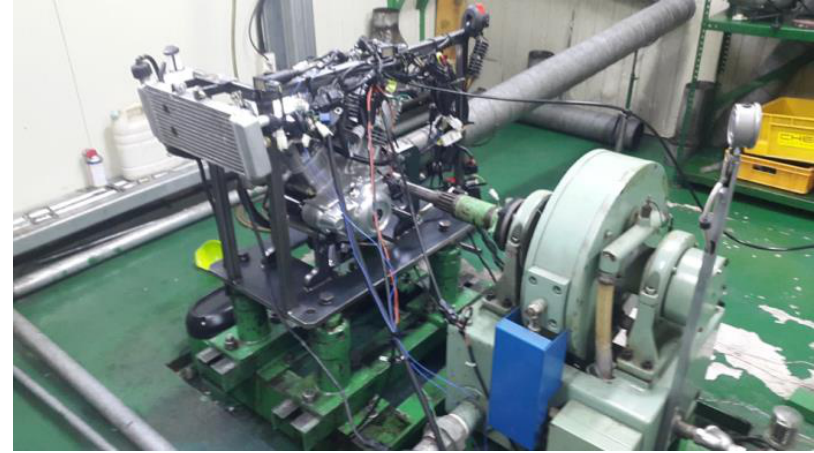
Figure 2. Experimental engine setup system.